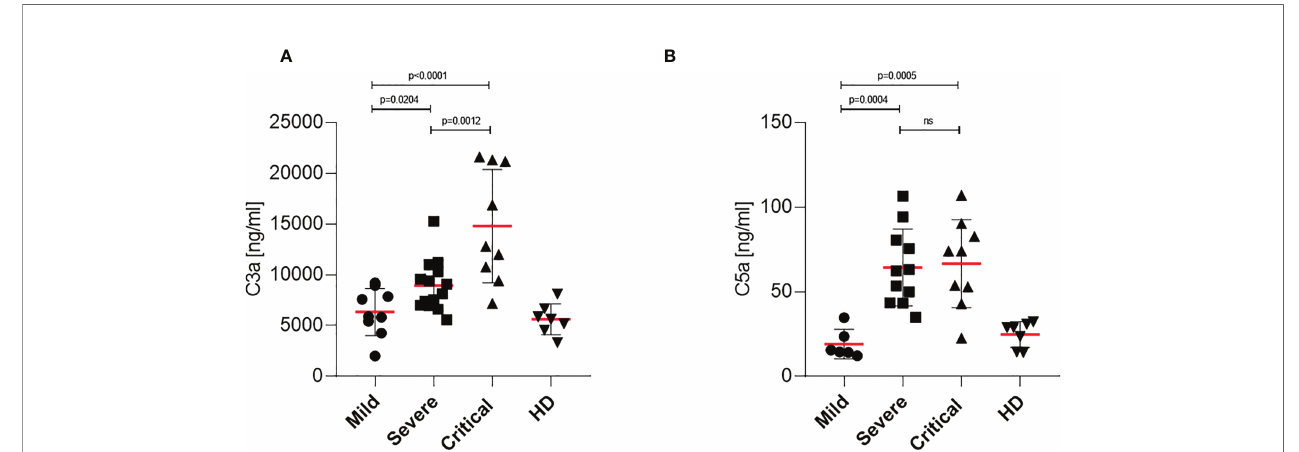
FIGURE 5 | Determination of anaphylatoxin levels in COVID-19 patients. (A) C3a level determination in mild, severe and critical COVID-19 patients as well as healthy donors. Plasma samples were harvested and C3a levels were analyzed using a BD Biosciences OptEIA Human C3a ELISA kit. (B) C5a level determination in mild, severe and critical COVID-19 patients as well as healthy donors. Plasma samples were harvested and C5a levels were analyzed using a BD Biosciences OptEIA Human C5a ELISA kit. C3a and C5a levels in ng/ml were determined for all patients and healthy donors and plotted on a bar graph. ns, not signi fi